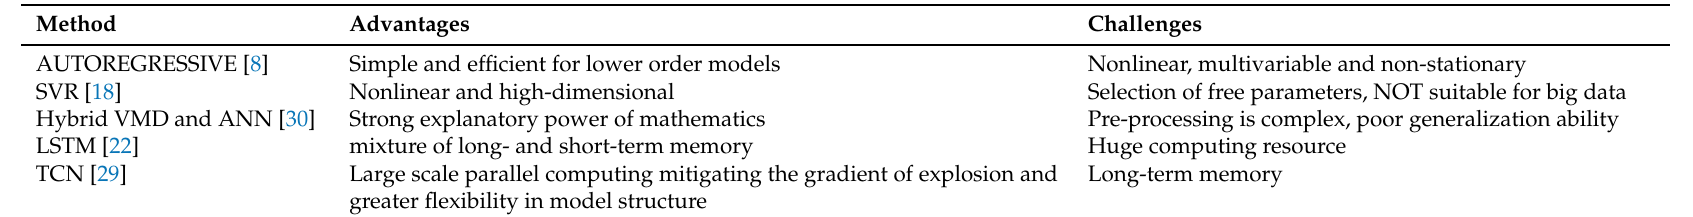
Table 1. Summary of advantages and challenges of time series prediction